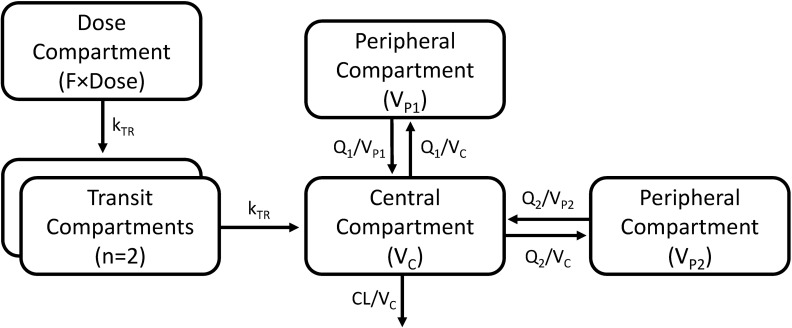
A graphical overview of the final piperaquine population pharmacokinetic model.kTR is the absorption transit rate constant. CL is the elimination clearance. VC is the volume of distribution of the central compartment. VP1 and VP2 are the volumes of distribution of the first and second peripheral compartments, respectively. Q1 and Q2 are the inter-compartment clearances for the first and second peripheral compartments, respectively. F is the relative oral bioavailability.